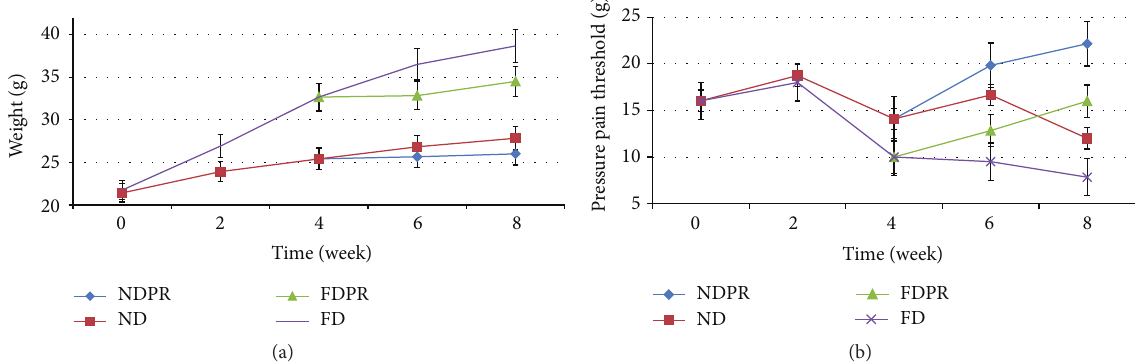
Figure 1: The abilities of L. rhamnosus PB01, DSM 14870, to reduce body weight (a) and increase pressure pain threshold (b) in mice fed normal diet (ND), high fat diet (FD), normal diet with probiotics (NDPR), and fat diet with probiotics (FDPR) during 8 weeks. Data are means ( 𝑛 = 6 ) and whiskers indicate SD (standard